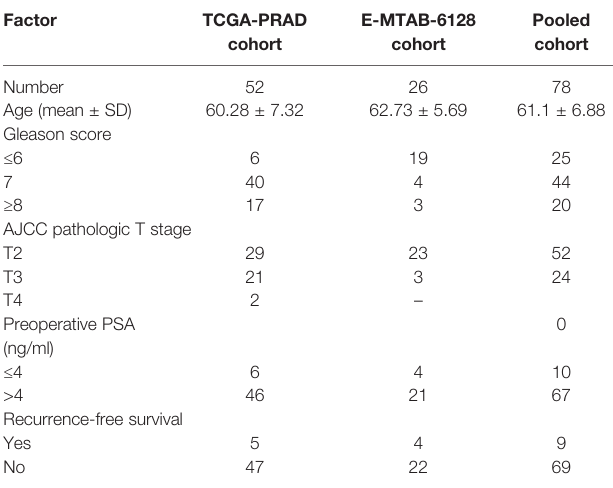
TABLE 1 | Clinical characteristics of selected sample in TCGA-PRAD project, E-MTAB-6128, and pooled cohort.